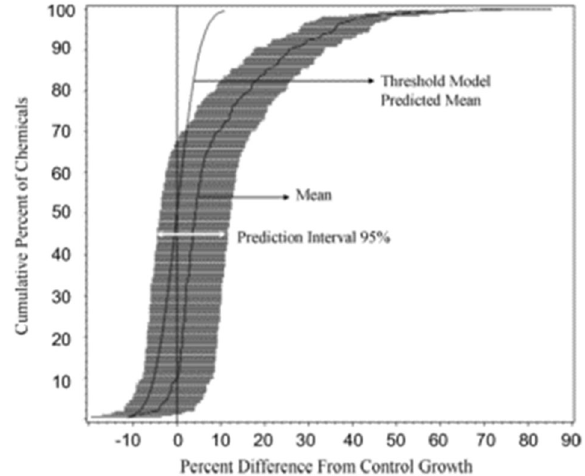
Fig. 3 Distribution of predicted mean response and 95% prediction interval values of the 253 chemicals satisfying the a priori entry criteria for the wild-type strain with three responses below the BMD 5 . These fi ndings are compared to expectations for a threshold model (Source: ref.